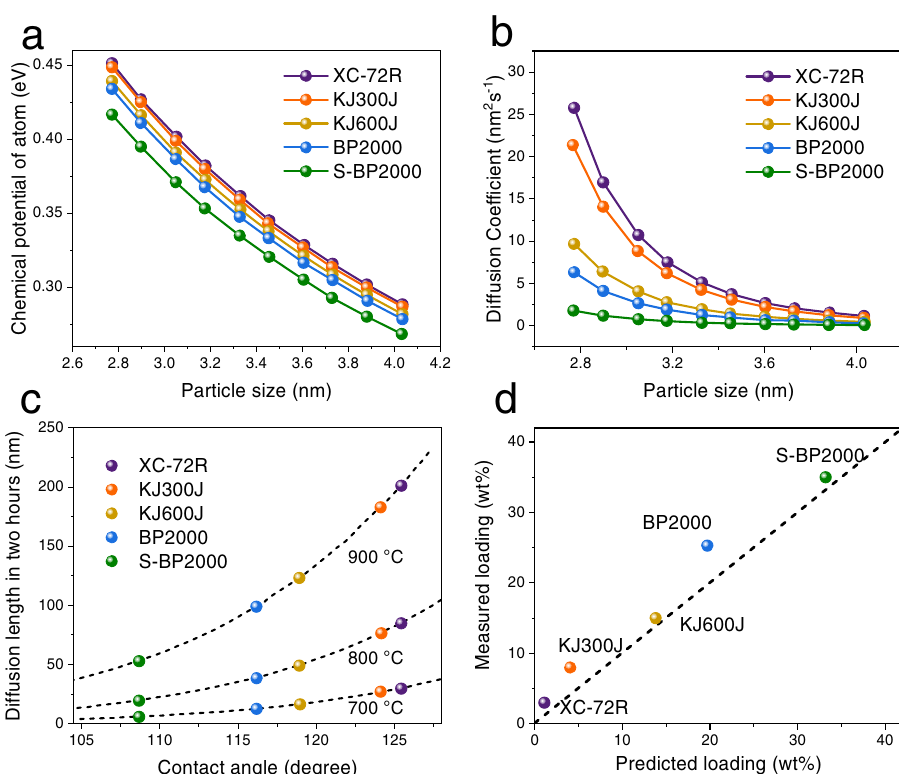
Fig. 5 Computation study. a Chemical potential of atoms in Pt nanoparticles on these fi ve carbon supports. b Size dependence of diffusion coef fi cient of Pt nanoparticles on the fi ve support surfaces at 900 °C. c Characteristic diffusion length of Pt nanoparticles in two hours versus the contact angles of Pt on these fi ve carbon supports under different temperatures. d Measured critical Pt loading versus the theoretically predicted one. The prediction was based on the calculated characteristic diffusion length and measured speci fi c surface area of the carbon